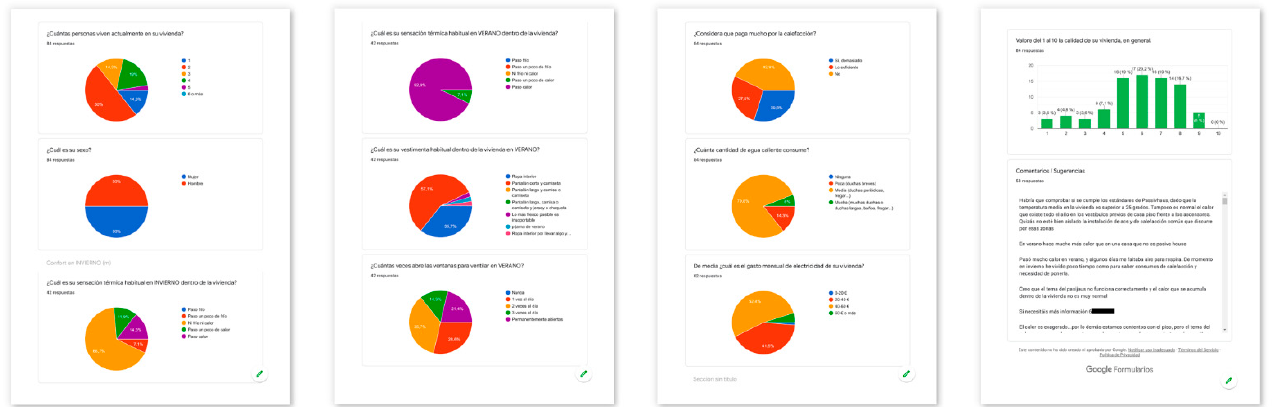
Figure 7. Snapshots of the Bolueta Tower 1 post-occupancy evaluation survey for thermal comfort. Source: authors.